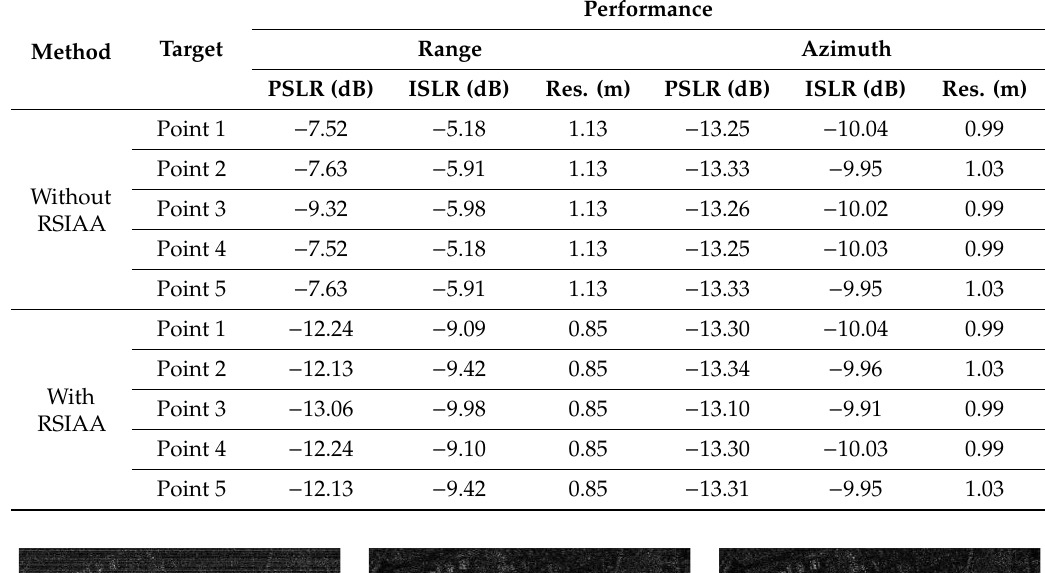
Table 8. The performance of five points.